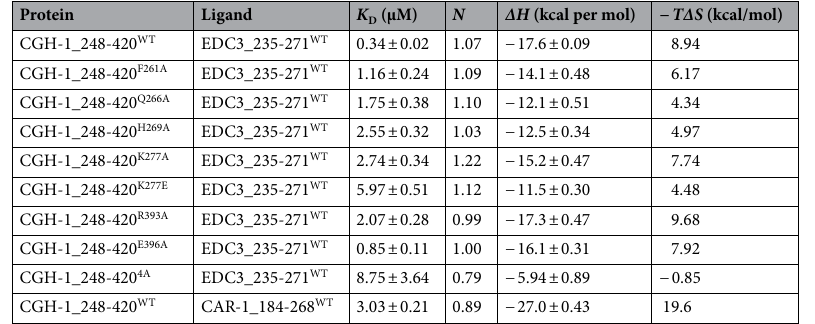
Table 1. Thermodynamic parameters of the CGH-1 248–420 (or its mutants) bound to its ligand EDC-3 235–271 by ITC assays.